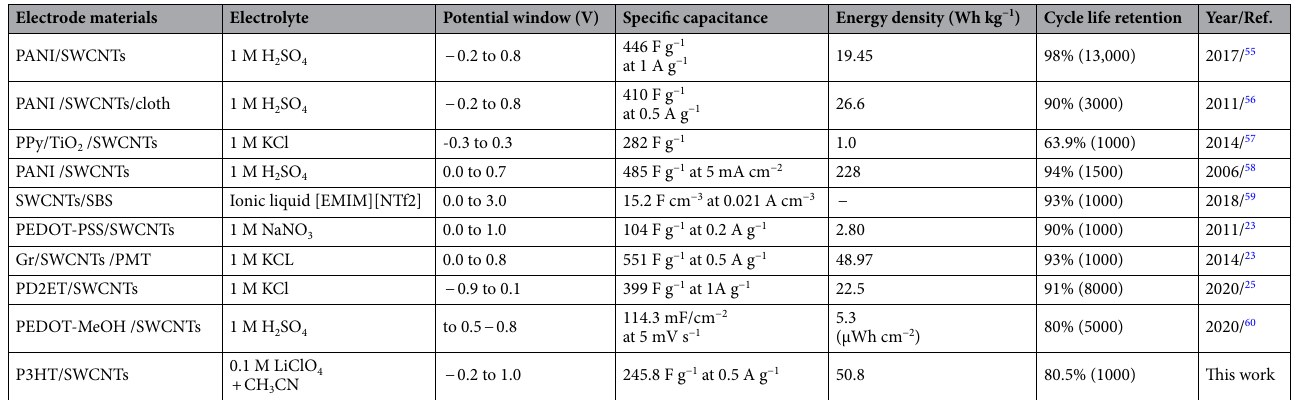
Table 1. Supercapacitor parameters of various polymers/SWCNTs electrodes presented in literatures and the present work. PAN polyaniline, PPy polypyrrole, TiO 2 titanium dioxide, SBS